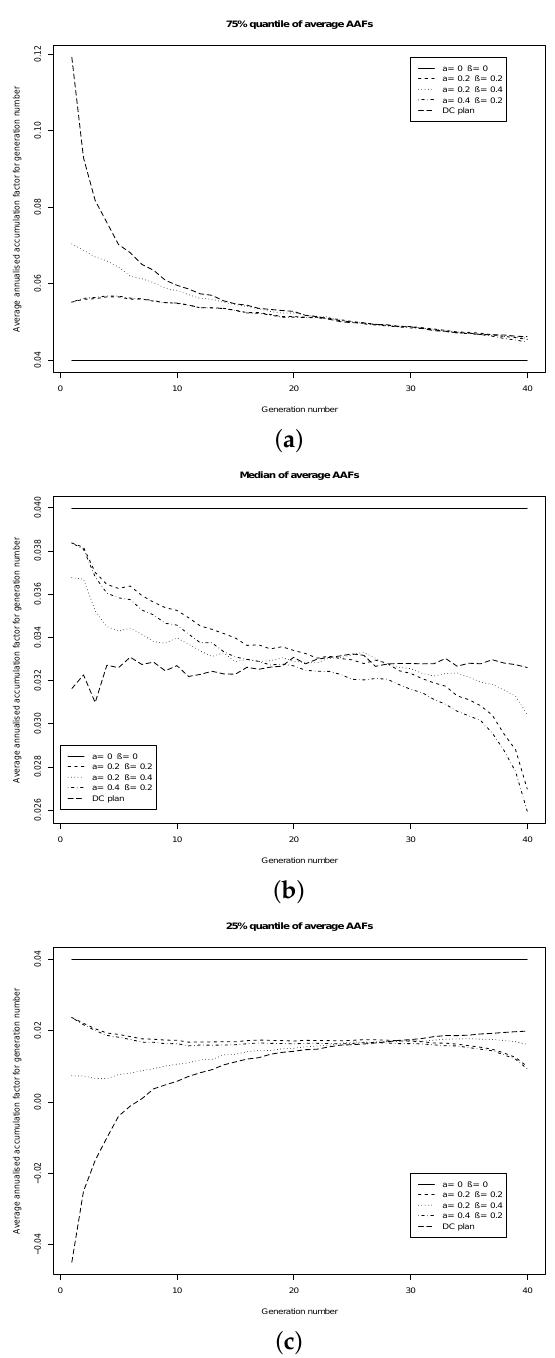
Figure 5. The annualized average accumulation factor for each generation in the model, for the more realistic membership, as both the investment risk adjustment ( a ) and the AAF adjustment ( b ) are varied. The target funding level is ¯ F = 100%. In this membership profile, the k th generation contributes $ ( 40 (cid:0) k + 1 ) at time 0, and contributes a further $1 per annum at the end of each year that they are not retired. ( a ) 75% quantile, ¯ F = 100%; ( b ) Median, ¯ F = 100%; ( c ) 25% quantile, ¯ F =